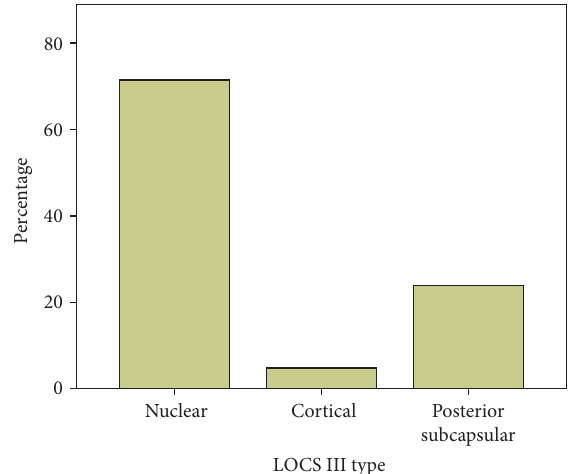
Figure 1: Histogram classifying the type of cataract according to the LOCS III system; this figure shows that 15 (71.4%) were nuclear, 1 (4.8%) was cortical, and 5 (23.8%) were posterior subcapsular.